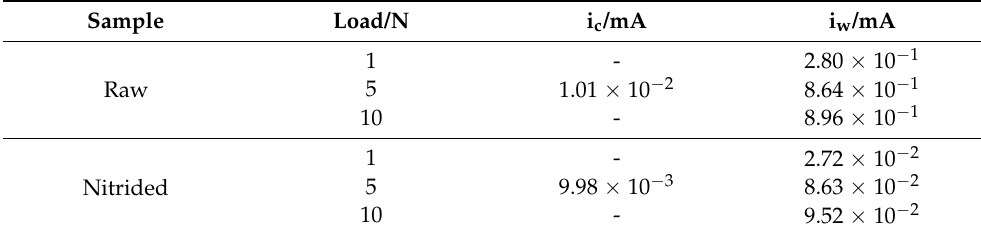
Table 3. Anodic currents of the raw and nitrided samples under different